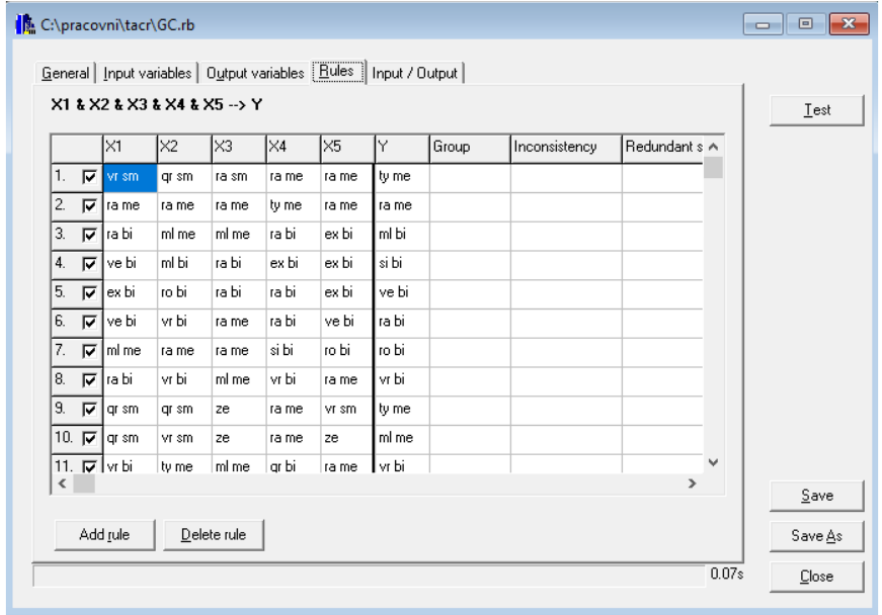
Figure 9. Partial rule base after learning.